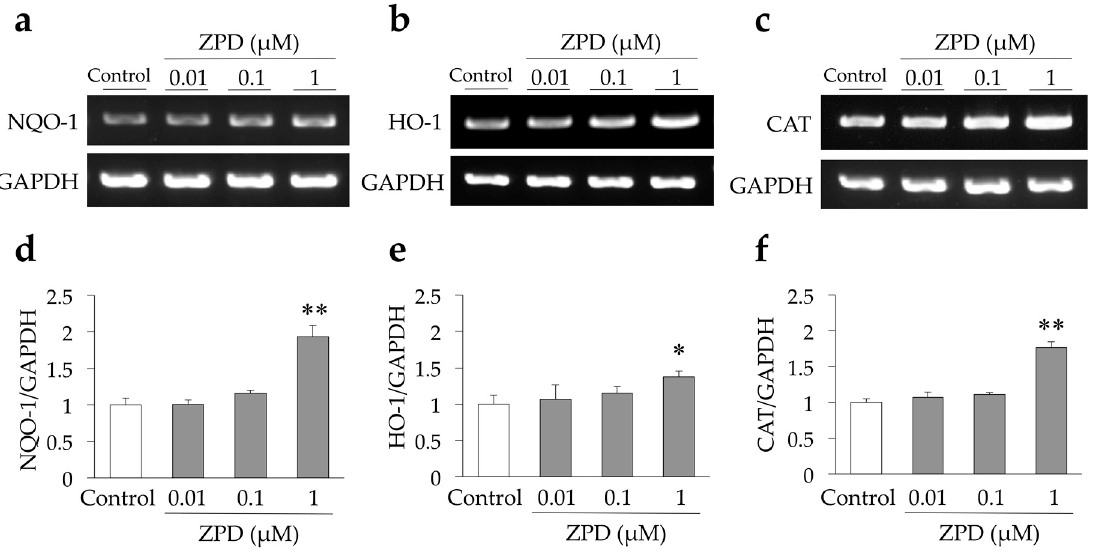
Figure 3. Effect of ziprasidone (ZPD) on the gene expression of NQO-1, HO-1, and CAT in PC12 cells. ( a – c ) PC12 cells were treated with 0.01–1 µ M ZPD for 24 h. The mRNA expression levels of NQO-1, HO-1, and CAT were determined by semiquantitative RT-PCR as described in Section 4. GAPDH was used as internal control. ( d – f ) Quantification of mRNA expression of NQO-1, HO-1, and CAT normalized with GAPDH mRNA intensity (d, NQO-1/GAPDH; e, HO-1/GAPDH; f, CAT/GAPDH). Experiments were repeated at least three times, and the values represent the mean of three experiments ± standard deviation (SD). * p < 0.05 compared to Control. ** p < 0.01 compared to Control.